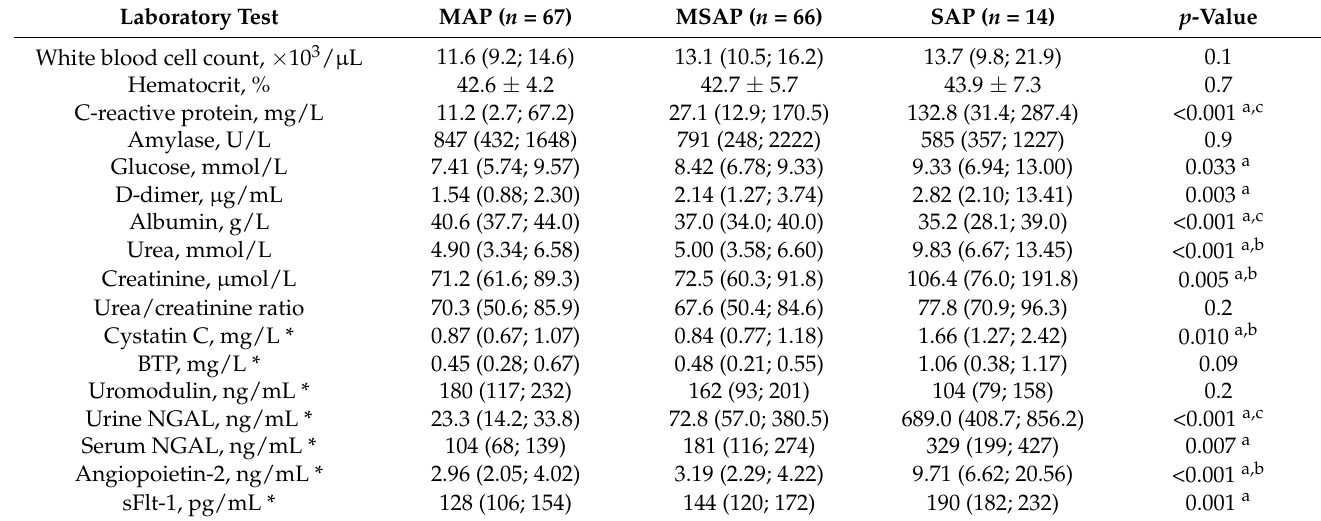
Table 2. The results of laboratory tests on admission (day 1). Data are presented as median (lower; upper quartile) or mean ± standard